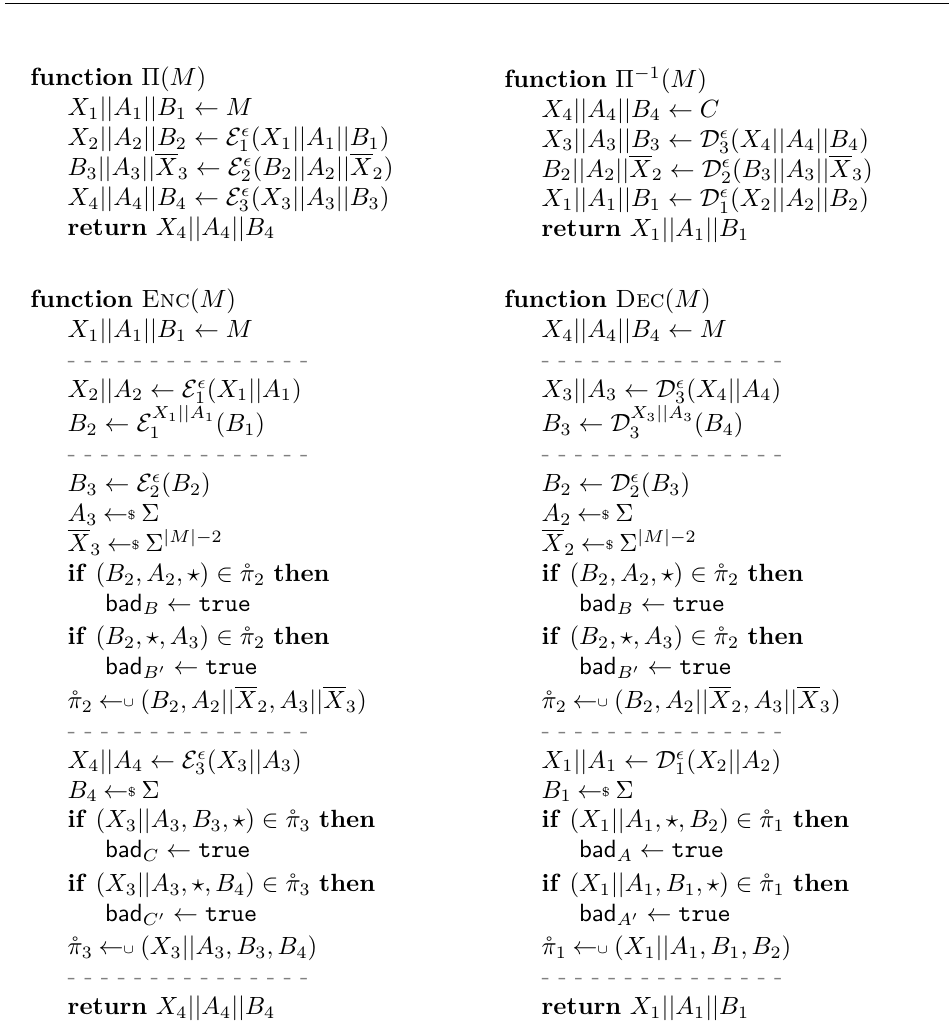
Figure 16: The scheme Π rev as oracles (E,D), followed by a construction (Enc , Dec) that 3 is identical-until-bad. To generate (Enc , Dec) out of (E,D) one applies Lemma 5 to swap out E 2 , D 2 , E 3 and D 1 . The dashed lines are for guidance only, and separate the elements of the routine coming from each of the three ideal online permutations. The parsing of M is done such that for a message of length m , | X | = m − 2 ≥ 0 and | A | = | B | = 1. Since (Enc , Dec) are identical to random permutation until bad , bounding bad also bounds the distinguishing advantage against Π rev 3